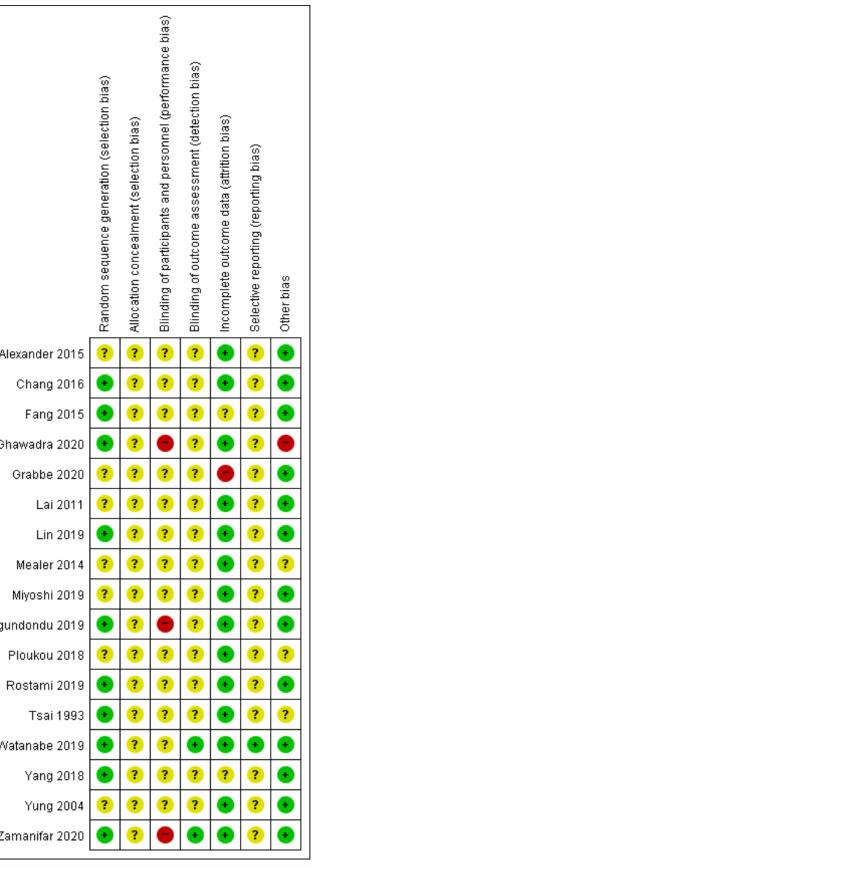
Figure 2. Risk of bias summary for all included studies. Low, unclear, and high risk, respectively, are represented with the following symbols: “+”, “?”, and